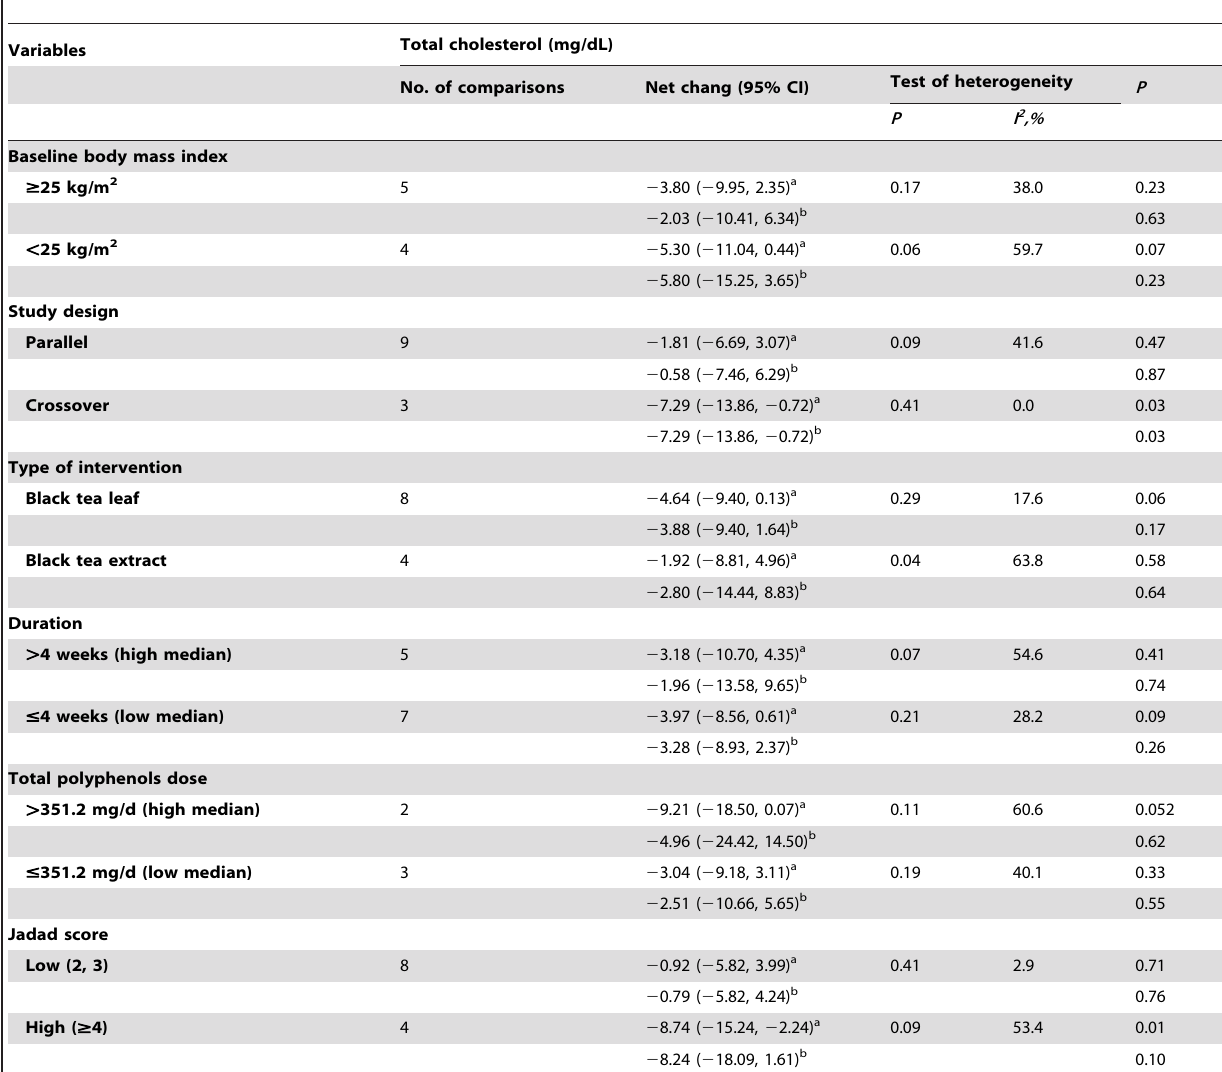
Table 2. Subgroup analyses of effect of black tea on TC concentrations in healthy subjects stratified by previously defined study